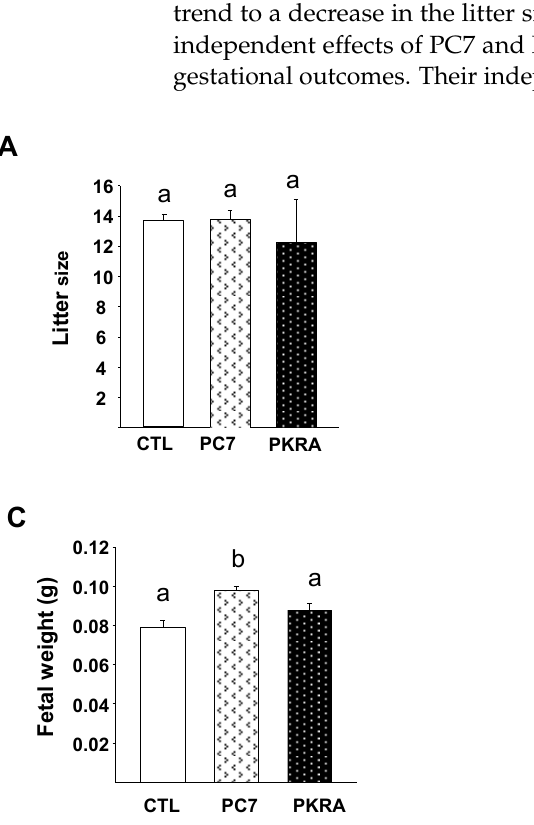
Figure 2. Effects of prokineticin antagonists’ PC7 or PKRA on gestation outcomes. ( A ) depicts a graph that compares the litter size of gravid mice treated or not by PC7 or PKR-A. ( B , C ) report graphs that compare placenta and fetal weights of pups born from mother treated or not by PC7 or PKRA, respectively. ( D ) reports graph that compare placental efficiency of mice treated or not by PC7 or PKRA. Data are presented as mean ± SEM. p < 0.05. Bars with different letters are significantly different from each other.